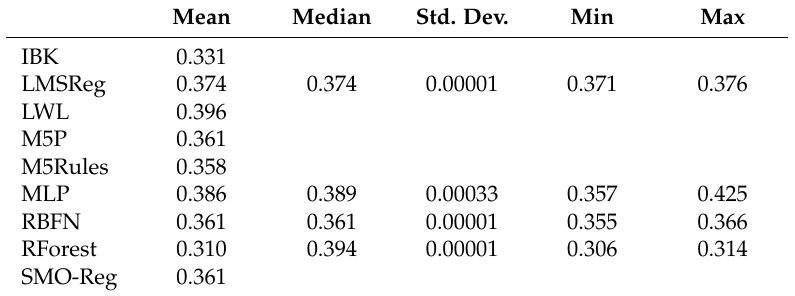
Table 3. Descriptive statistics of mean RMSE for underpricing on test set based on 15 experiments. Mean Median Std. Dev.